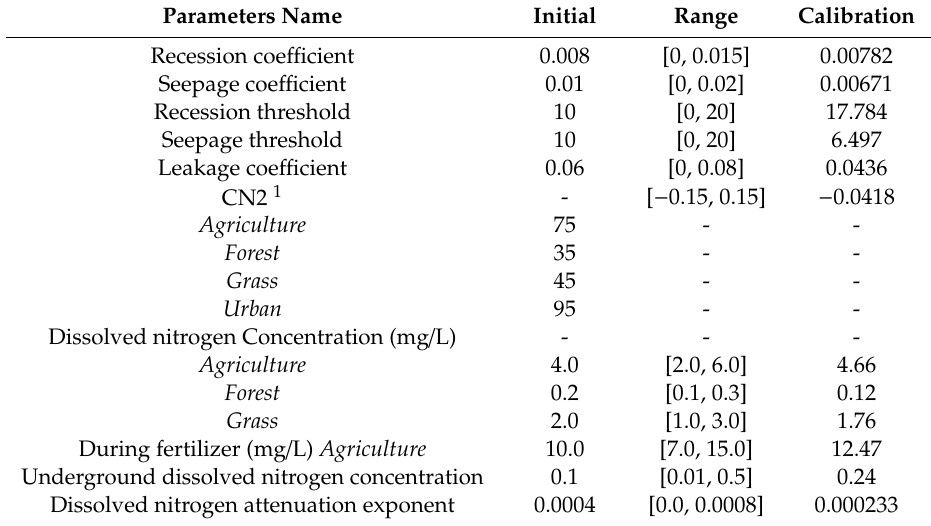
Table 3. Parameters selected for the calibration.